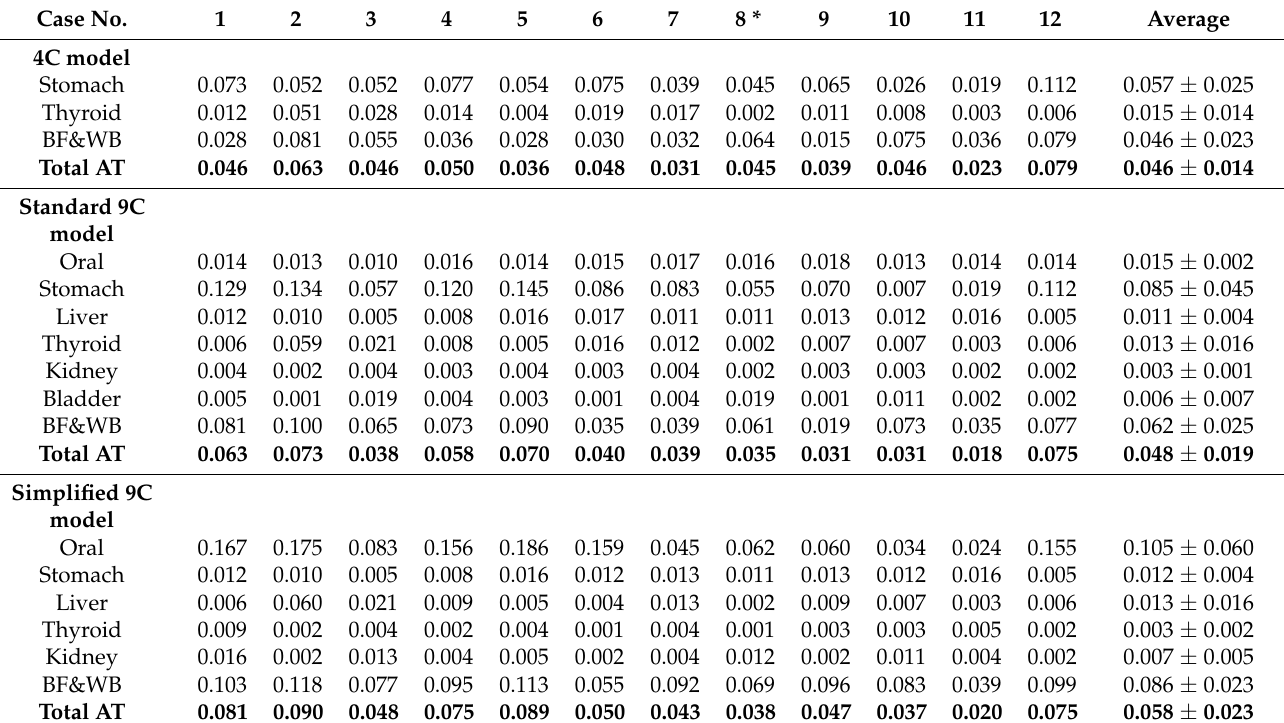
Table 4. The AT values of the derived compartments for twelve patients. AT indicates the curve- fitting agreement between the theoretical estimation and the empirical measurement for each specific compartment of the patient’s body. * Case no. 8 was excluded from the calculations of average